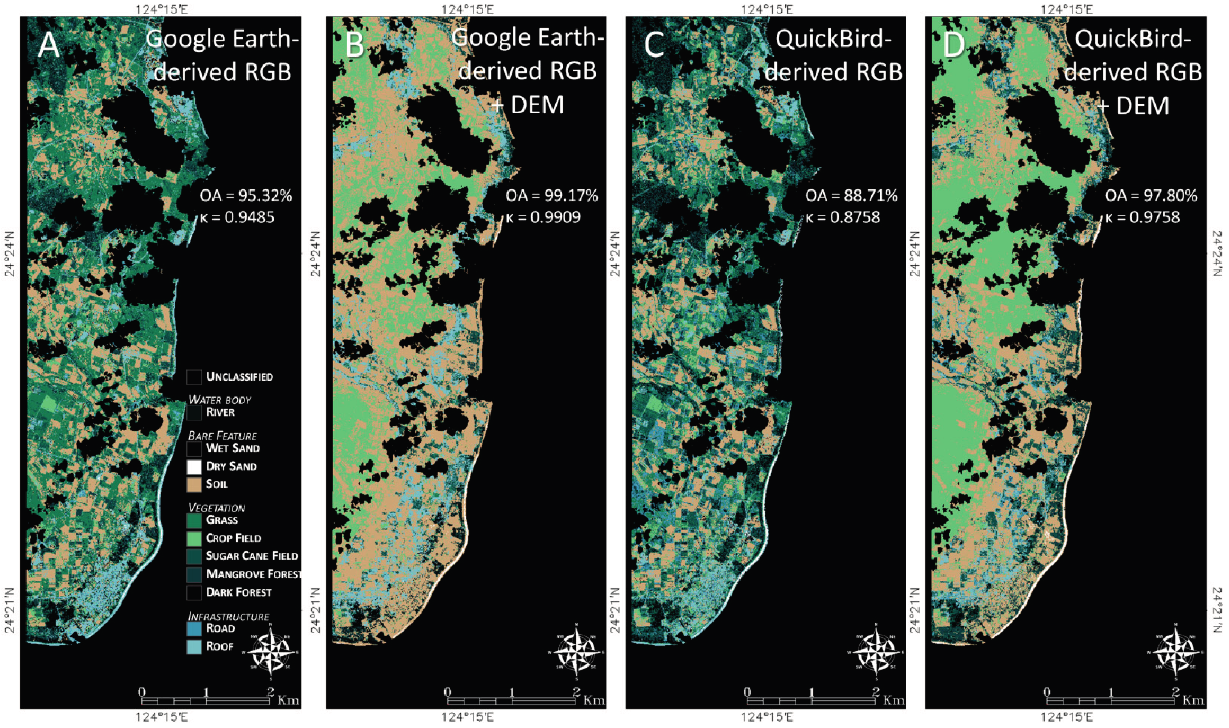
Figure 9. Land cover maps (11 classes) resulting from the Google Earth-derived very high resolution mosaic ( A ) without and ( B ) with an inherent digital elevation model (DEM) and from the pansharpened QuickBird imagery ( C ) without and ( D ) with an inherent DEM. For each map, the overall accuracy (OA) and kappa coefficient ( κ ) are overplotted.